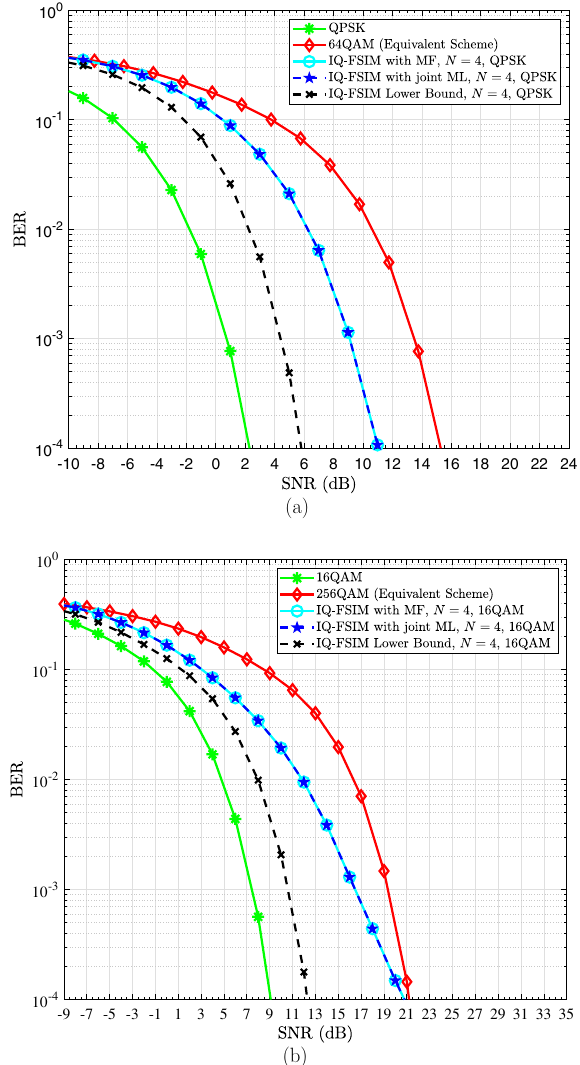
Fig. 12 BER performance for 4-IQ-FSIM- M QAM, its theoretical lower bound, and its equivalent scheme 16 M QAM of the same SE: a 6 bpcu using M = 4 , b 8 bpcu using M =